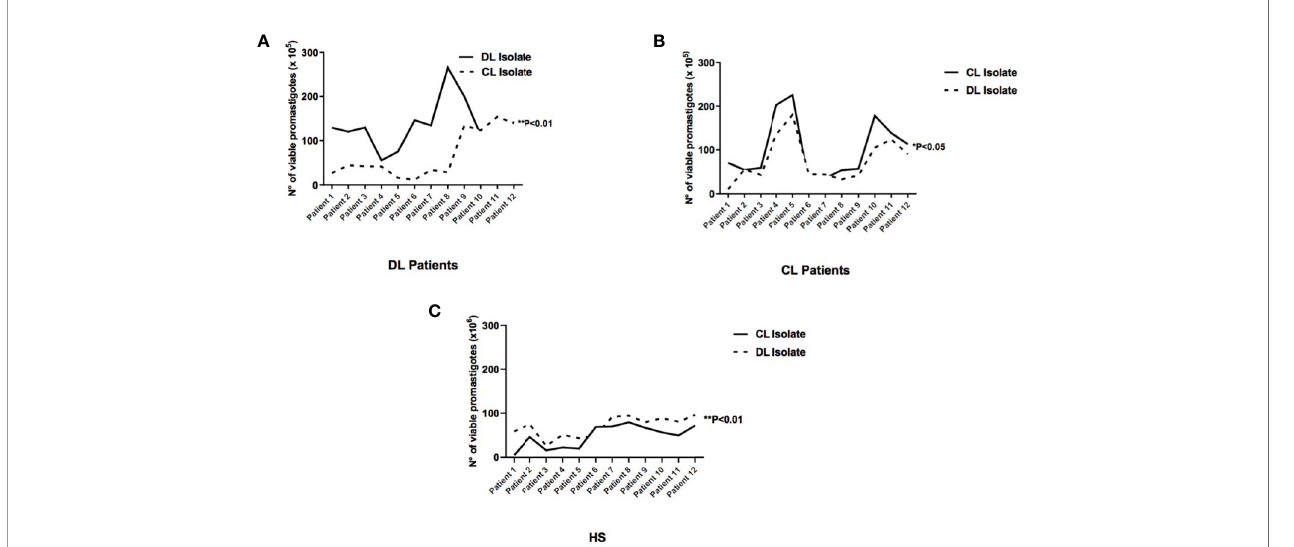
FIGURE 3 | Viability of extracellular promastigotes in the supernatants of cultured monocytes from patients with DL, CL or healthy subjects following infection with different L. braziliensis isolates: PBMC from patients with DL (n=12), CL (n=12) or HS (n=12) were infected with different isolates of L. braziliensis (DL or CL) for 48 hours. After this period RPMI medium was replaced by Schneider culture medium for another 48 hours. The number of viable promastigotes was evaluated by optical microscopy. (A) Monocytes from patients with DL; (B) Monocytes from patients with CL; (C) Monocytes from HS. Results are expressed as median values and statistical analysis was performed using the Wilcoxon ’ s signed-rank test. Comparisons between groups were performed using the Mann-Whitney statistical test (*p < 0.05) (**p < 0.01).